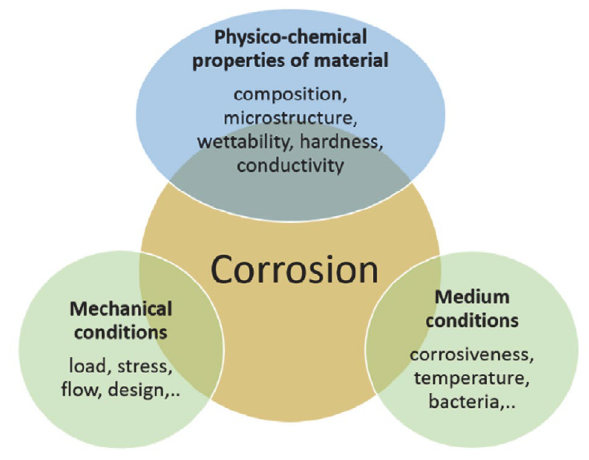
Figure 1. Factors influencing corrosion process of metal